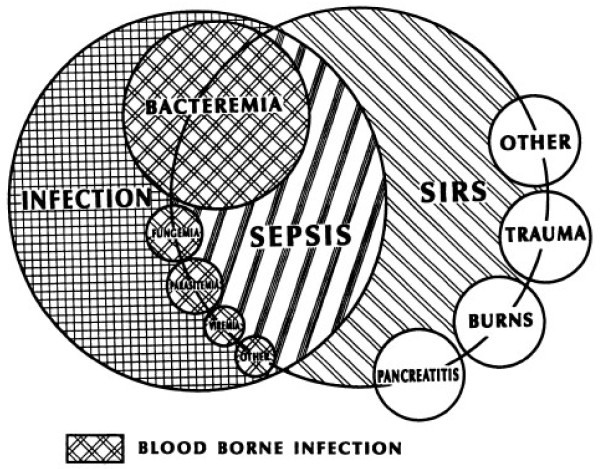
The interrelationship between systemic inflammatory response syndrome (SIRS), sepsis, and Infection. Used with the permission of CHEST.License number2835980252893.